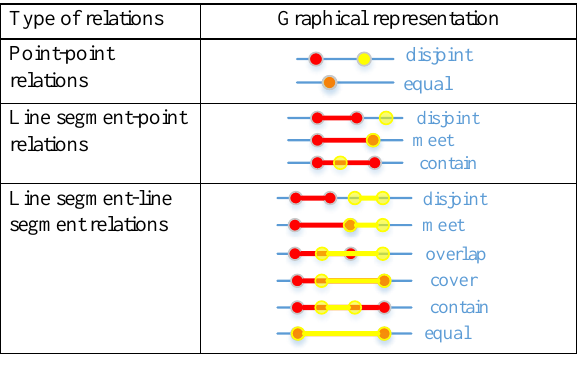
Table 2. Basic topological relations between primitives in the intersection line of two planes (red primitives are the intersections between planar region A and the intersecting line, and yellow parts are the intersections between planar region B and the intersecting line)